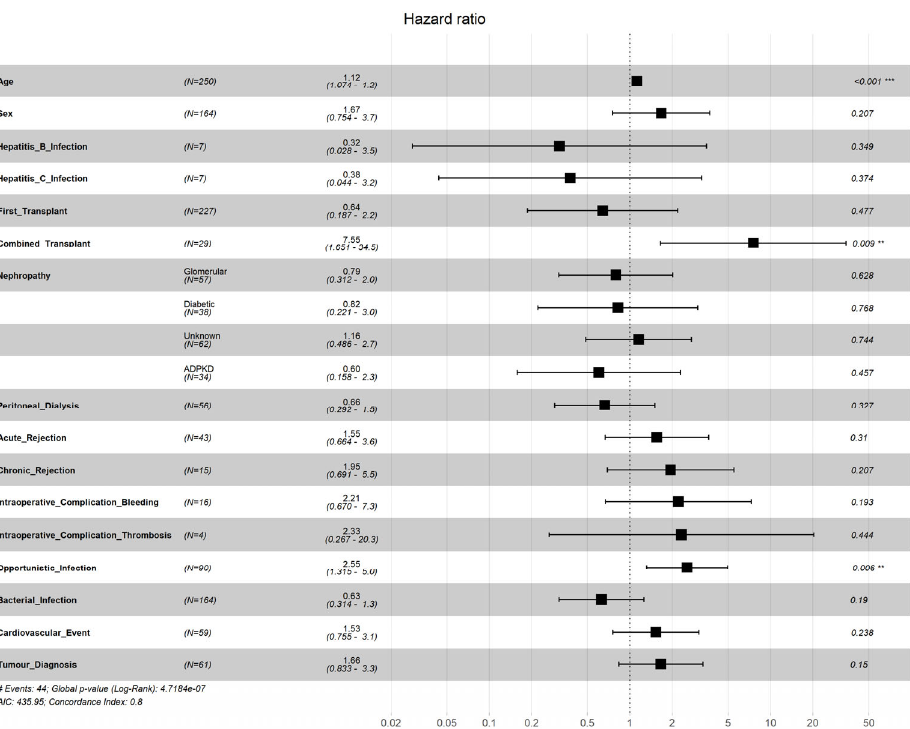
Figure 4. Results of the Cox proportional hazards model for overall survival, including the most significant studied variables. ** p ‐ value < 0.01, *** p ‐ value < 0.001.